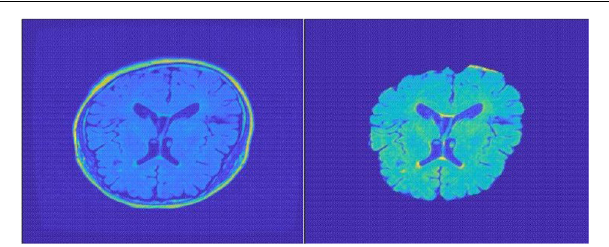
FIGURE 2 | Top view of MR image: the left one is before separation; the right one after separation.